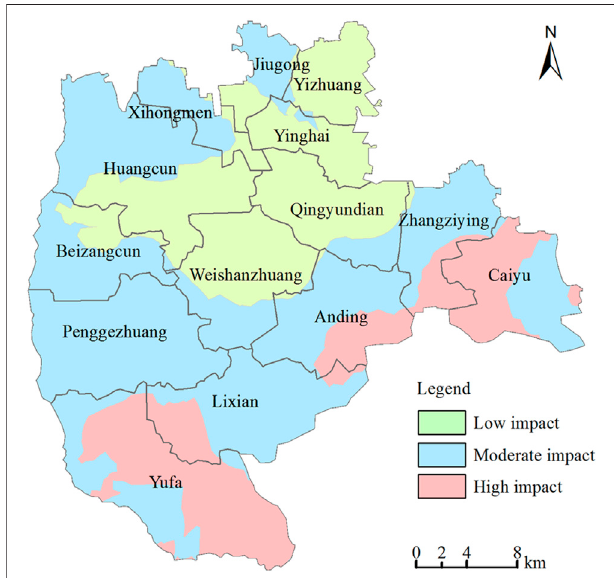
FIGURE 9 | Spatial distribution of the in fl uence degree of human factors on the groundwater chemical composition.